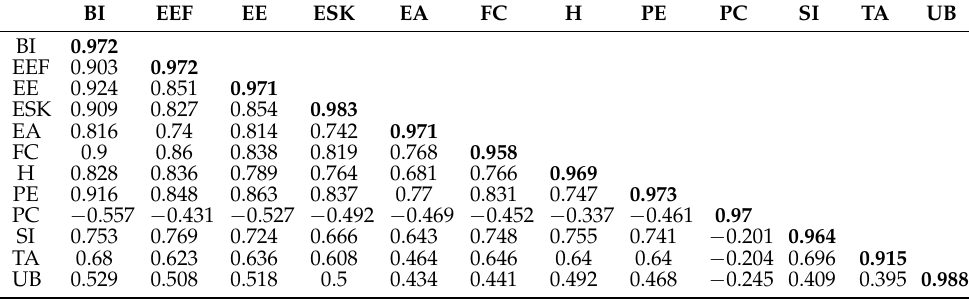
Table 4. Correlations between constructs compared to square roots of AVE.